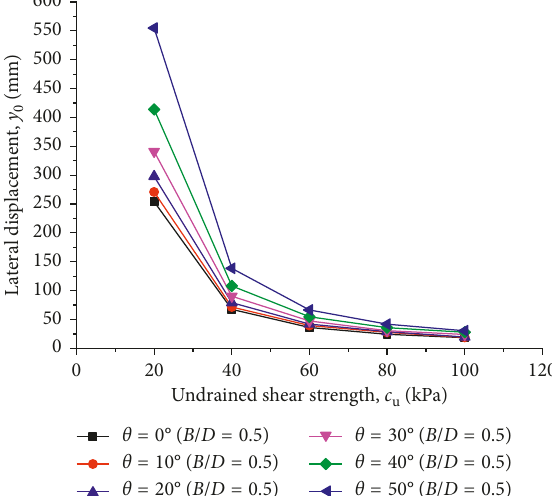
Figure 22: Maximum bending moment ( M adhesion coefficient ( α ) for different slope angle.